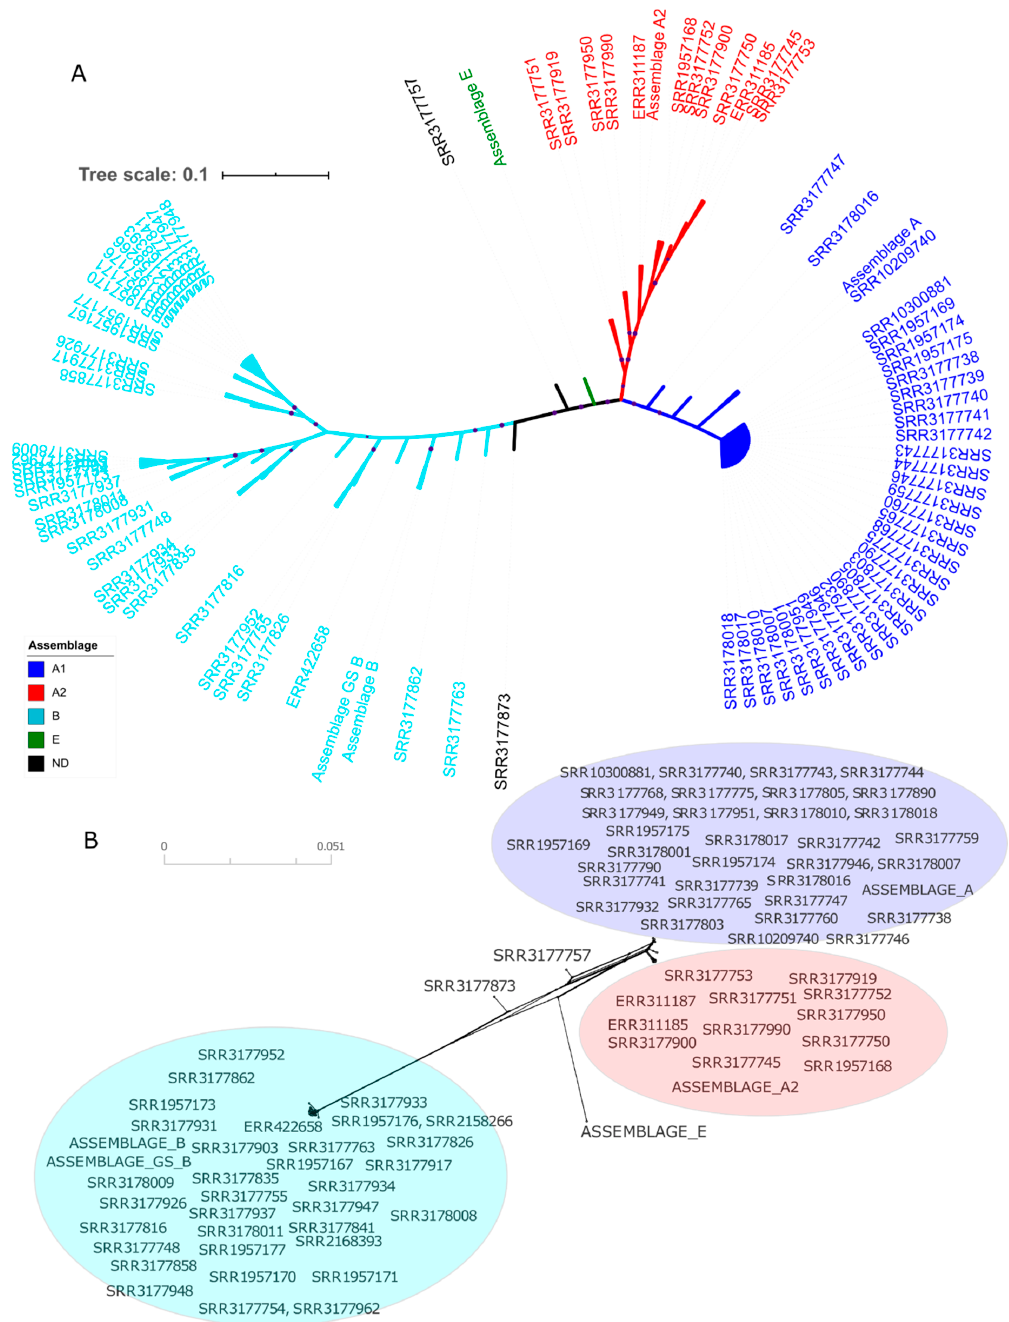
Figure 1. Phylogenetic reconstructions with sequences obtained from WGS data. Phylogenetic inferences were constructed from concatenated sequences of the nine selected genes. ( A ) Phylogenetic tree constructed from the alignment of concatenated sequences of all the genes evaluated. The tree was constructed with FastTree [45] software and visualized with ITOL [46] software. The maximum likelihood (ML) method was used under the Jukes Cantor nucleotide evolution model, with a Bootstrap of 1000 repetitions. A Bootstrap value greater than 90% is represented with a purple circle above each node. The colours indicate the assemblage to which the evaluated sequences belong (Blue: AI, Red: AII, Turquoise: B, Green: E and ND: not defined). ( B ) A phylogenetic network, using Splitstree software [47], was built with the Neighbornet algorithm; the colours correspond to assemblages. The access numbers of the genomes used are